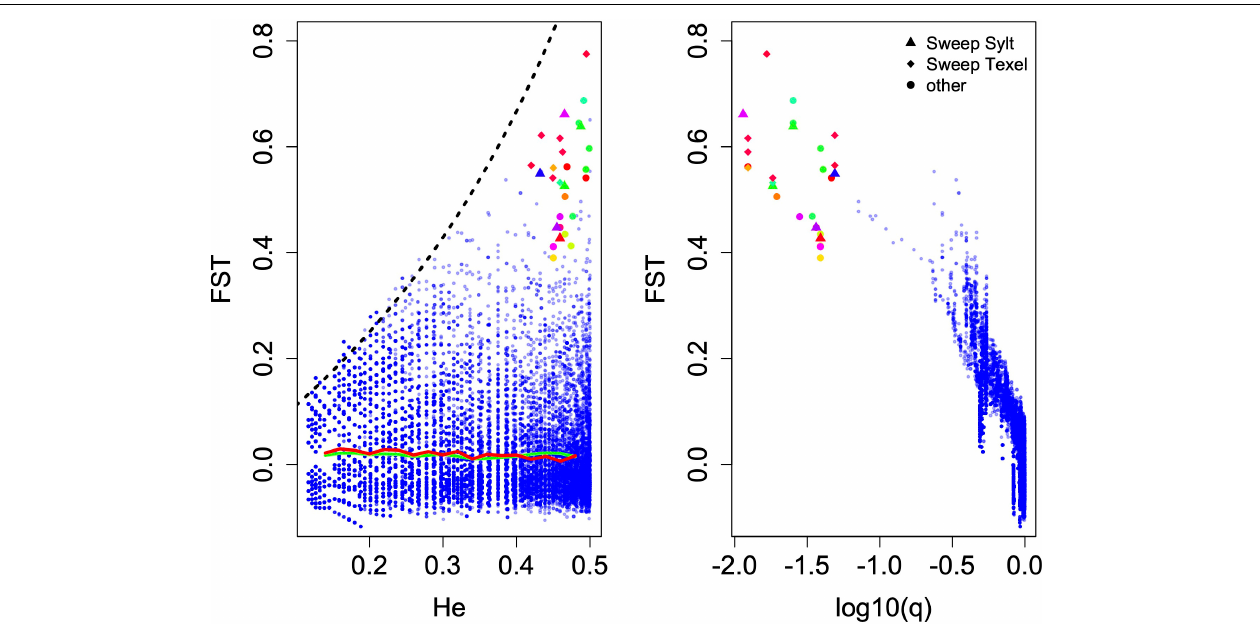
FIGURE 2 | Outlier detection in 36116 SNP loci with He > 0.1. (A) Genetic differentiation as a function of expected heterozygosity (He) and (B) as a function of q. Each blue dot represents one SNP. Genetic differentiation is limited by the theoretical upper bound (black dashed line) at lower heterozygosities and outlier loci were only detected in the range of expected heterozygosities from 0.42 to 0.5. Triangles and diamonds show loci that showed characteristics of selective sweeps in Sylt or Texel, respectively and colors of outlier loci indicate scaffold affiliation of these loci. The green line shows the average FST and the red line the FSTbar value for each sliding window across the He